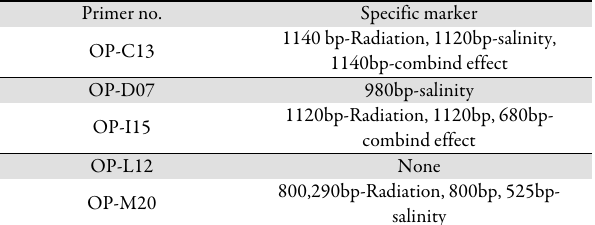
Table 5. Used primers and the specific markers generated for salinity, radiation and combined treatments Primer no.